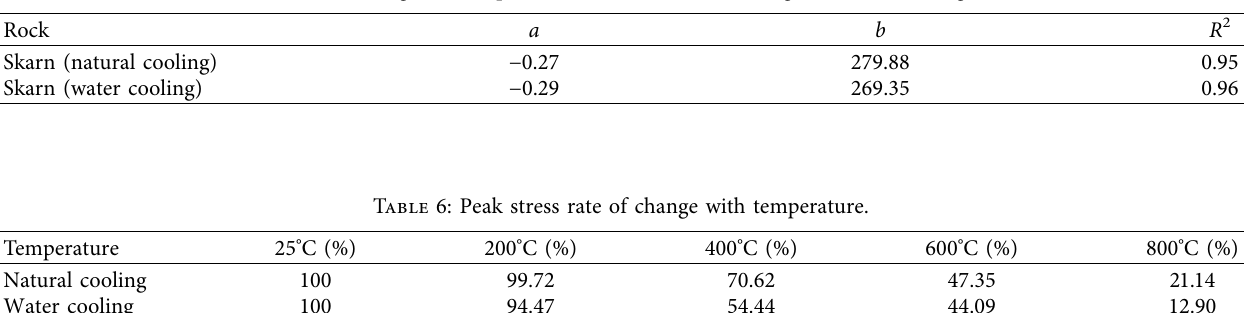
Table 5: Fitting formula parameter table (natural cooling and water cooling).